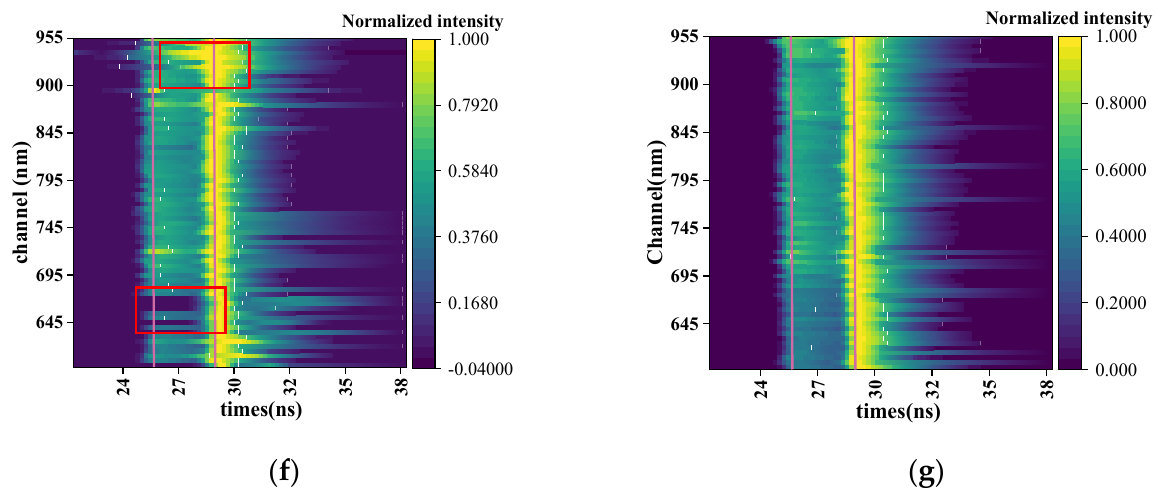
Figure 8. Results and comparison of two methods of distance retrieval. ( a – c ) Box diagrams of distance of two targets and distance difference after SCWD and MCMCD. ( d , e ) Schematic diagram of each channel’s waveform data after SCWD and MCMCD. ( f , g ) Top view of decomposition results in channel–intensity–time after SCWD and MCMCD, respectively. Table 5. Retrieval of distance information and evaluation using SCWD and MCMCD. Std, standard